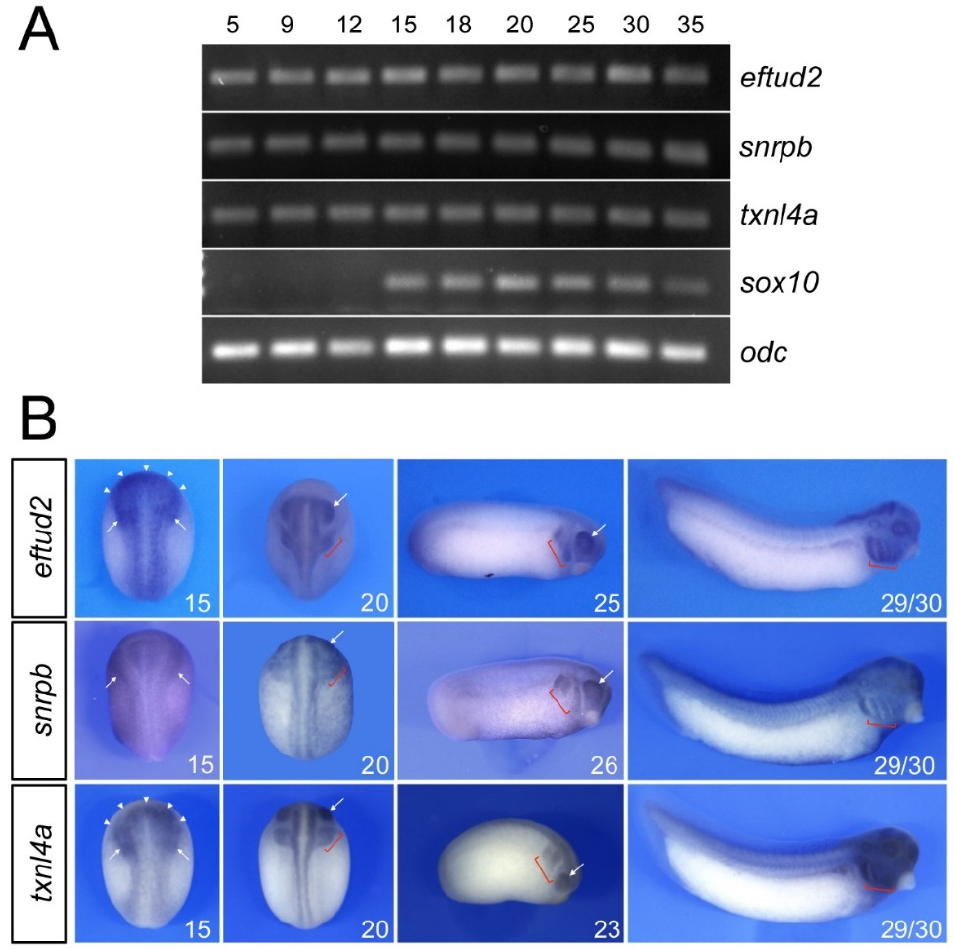
Figure 1. Developmental expression of eftud2 , snrpb and txnl4a . ( A ) RT-PCR analysis indicates that eftud2 , snrpb and txnl4a are expressed at all stages examined whereas sox10 is first activated at stage 15. odc is shown as a loading control. ( B ) At stage 15, eftud2 and txnl4a transcripts are enriched at the anterior neural plate (arrowheads) and the neural-crest-forming regions (arrows), whereas snrpb appears to be ubiquitously expressed. At stages 20 to 26, the three genes are enriched in the pharyngeal arches (brackets) and the eyes (arrows). At stage 29/30, the expression of eftud2 , snrpb and txnl4a is maintained in the pharyngeal arches (brackets). Stages 15 and 20 are dorsal views, anterior to top. Stages 23, 25, 26 and 29/30 are lateral views, dorsal to top, anterior to